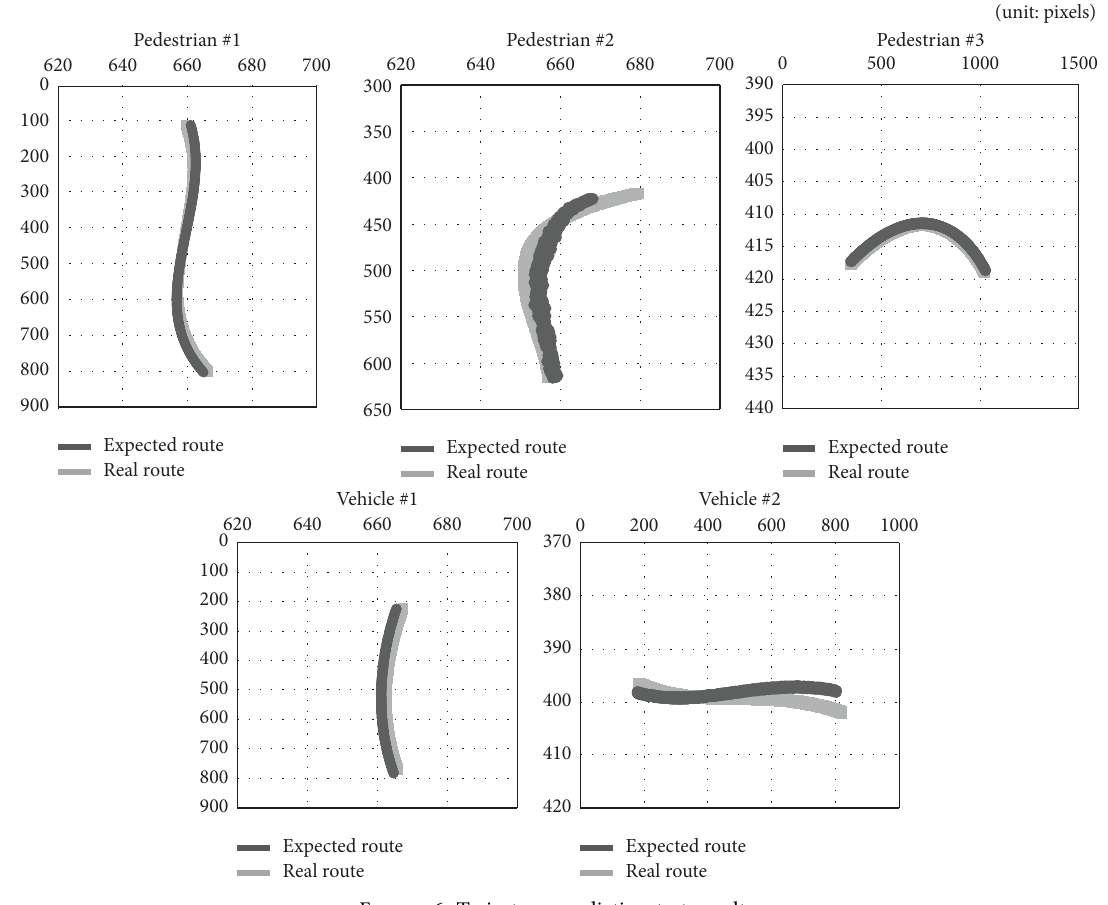
Figure 6: Trajectory prediction test results. Table 3: Trajectory prediction accuracy.